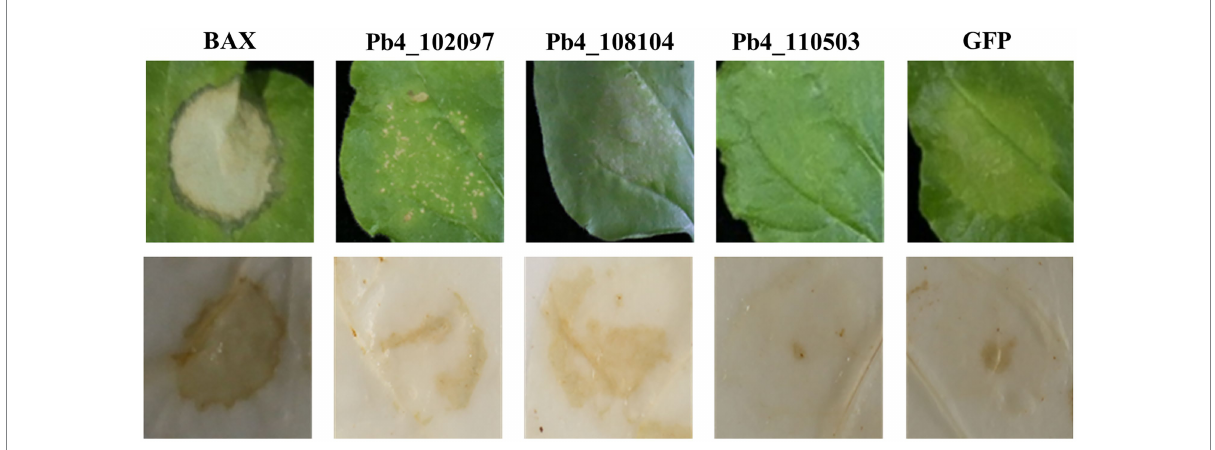
FIGURE 1 Putative effectors of Plasmodiophora brassicae induced programmed cell death and H 2 O 2 accumulation in Nicothiana benthamiana . Necrosis and